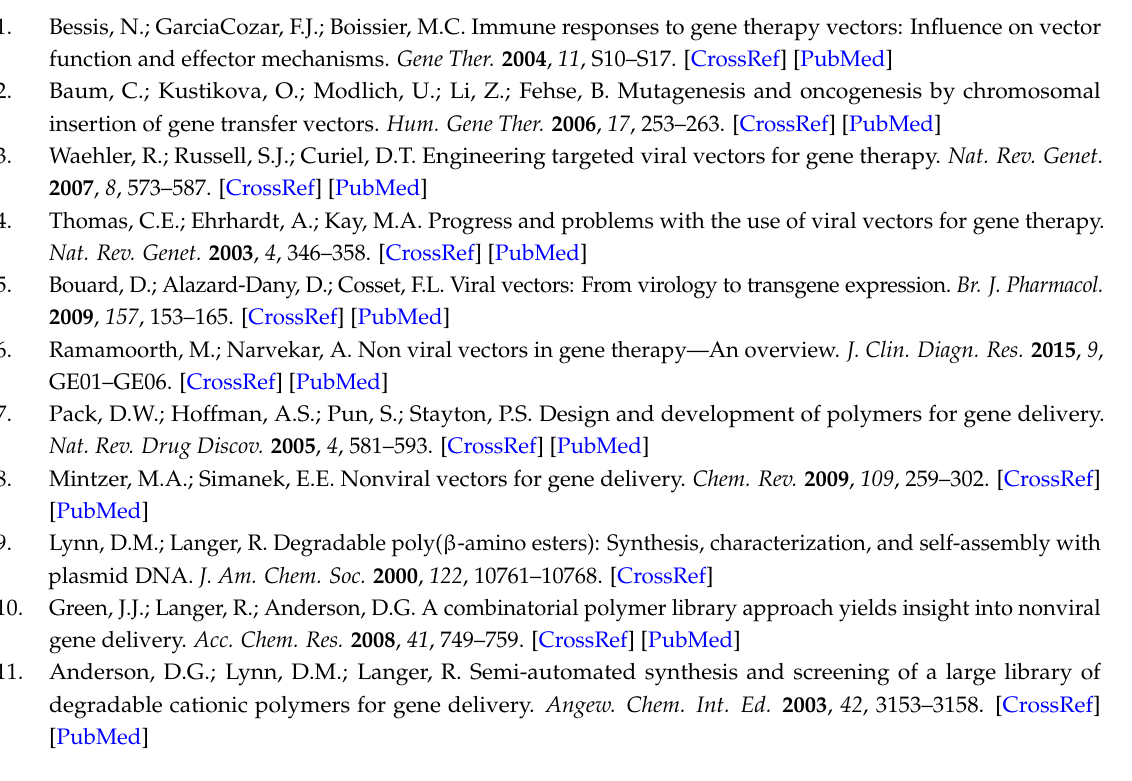
Table S1: Monomer feed ratios for the synthesis of LC32 and HC32 base polymers, Table S2: GPC results of LC32 and HC32 polymers, Table S3: PDI results of LC32/DNA, HC32/DNA, PEI/DNA and SuperFect/DNA polyplexes with different Polymer/DNA w / w ratios, Figure S1: Characterization of the LC32-103 and HC32-103 polymers, Figure S2: Cell viability assessment after transfections with polyplexes at different w / w ratios, Figure S3: Sizes of various polyplexes at different time points after incubation with different concentrations of serum, Figure S4: Sizes of various polyplexes at different time points after incubation with different concentrations of NaCl, Figure S5: Acid-base titration curves of various polymers, Figure S6: Normalized molecular weight of various polymers at different time points measured by GPC after incubation in deionized water, Figure S7: DNA release profiles from various HC32-103/DNA polyplexes, determined by Picogreen assays, Figure S8: Cell viability assessment after transfections with polyplexes at different w / w ratios: (a) Cell viability of HeLa cells; (b) Cell viability of RDEBK